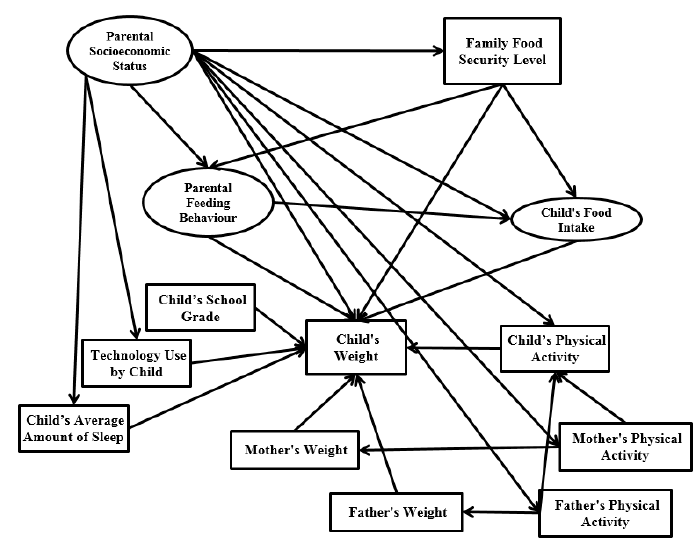
Figure 1. Research framework.